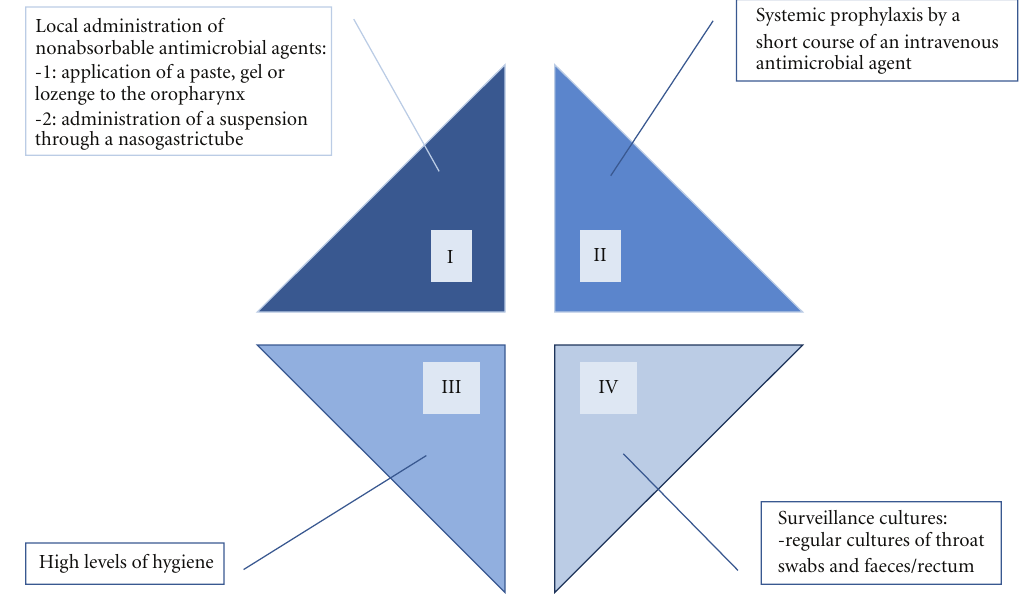
Figure 1: The 4 components of the original SDD